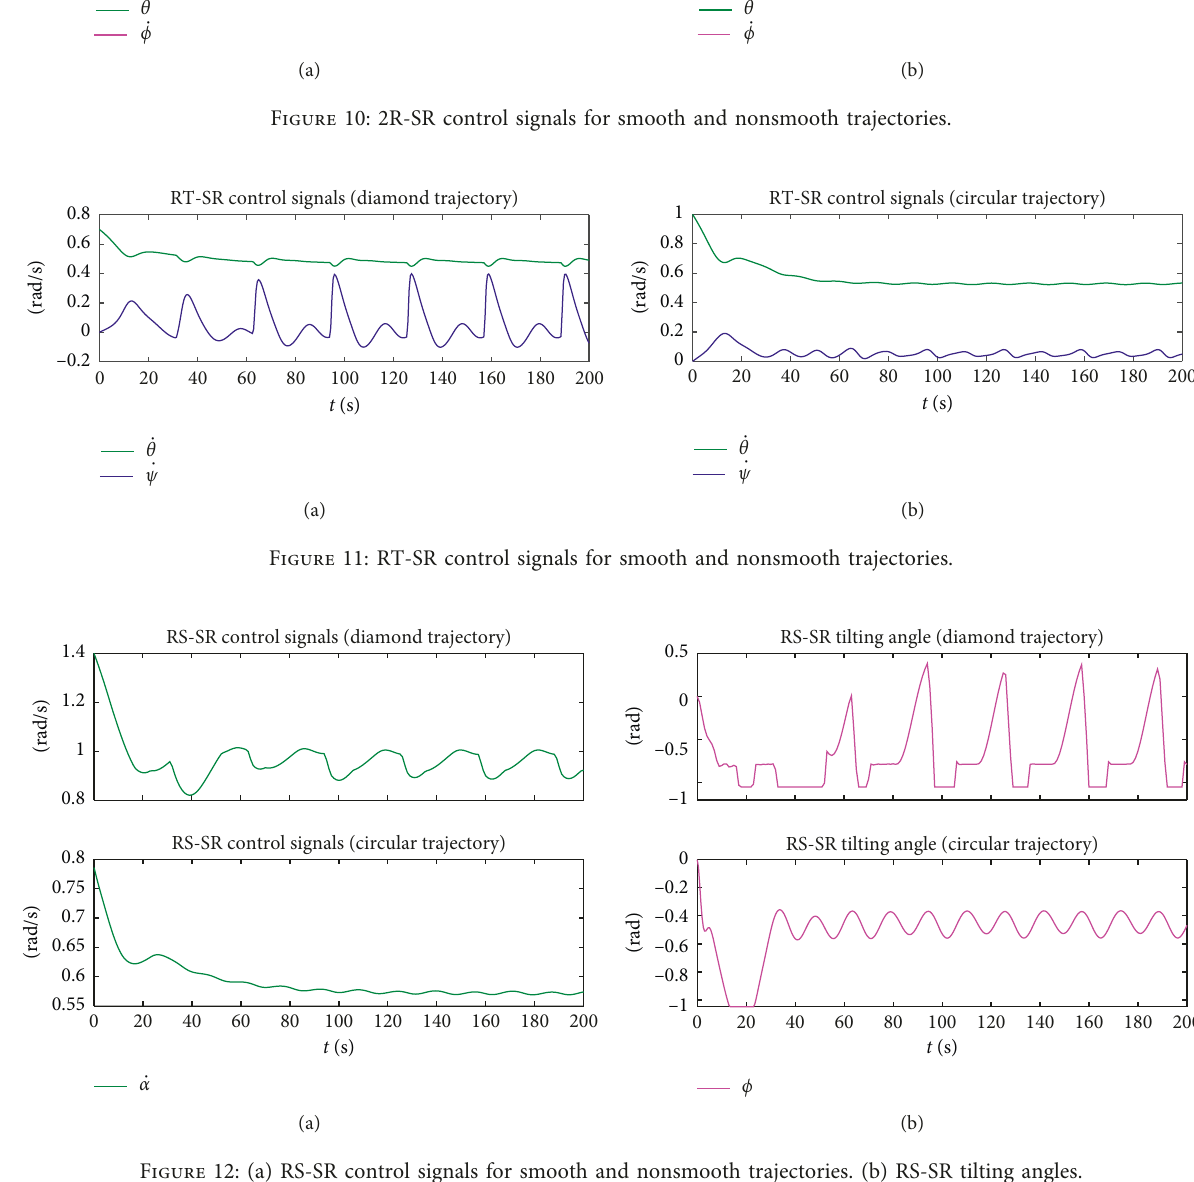
Figure 12: (a) RS-SR control signals for smooth and nonsmooth trajectories. (b) RS-SR tilting